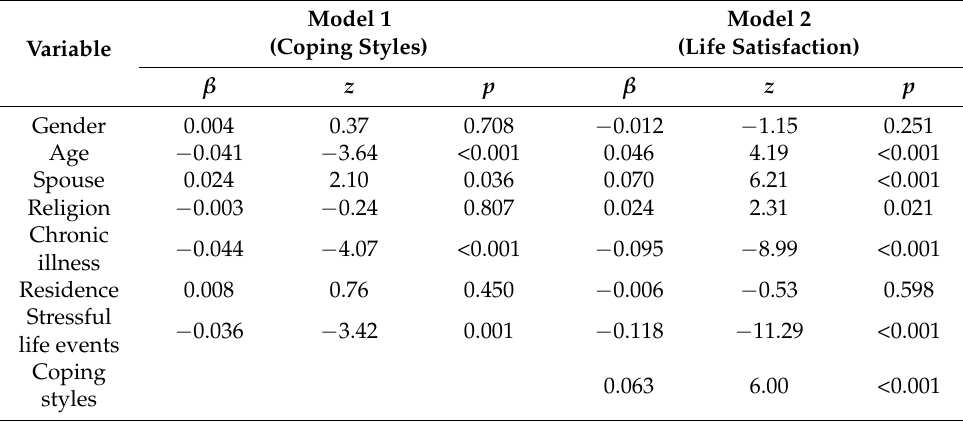
Table 3. Test of the mediation model ( n =